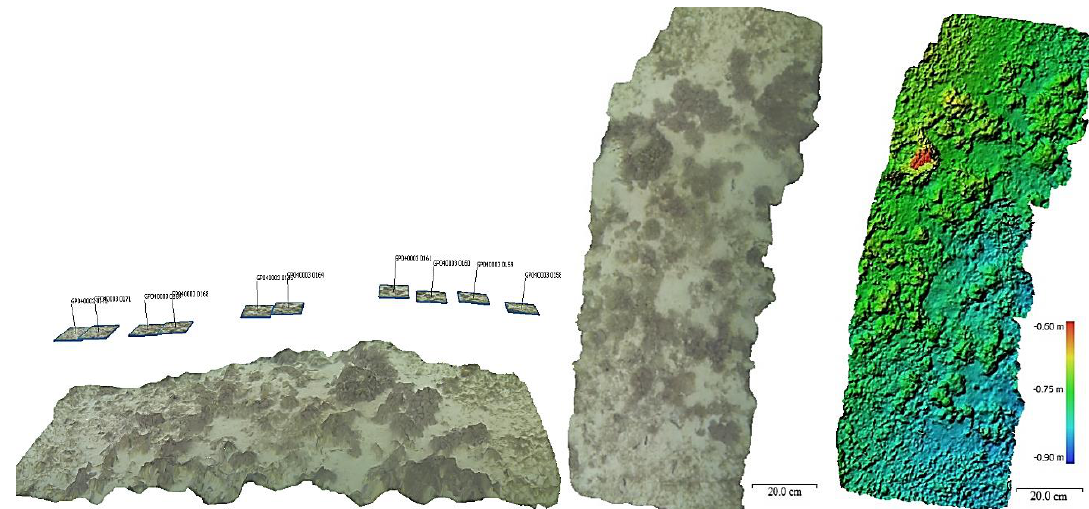
Figure 8. 3D perspective view, orthophoto mosaic, and DTM for a categorized brown algae sample.